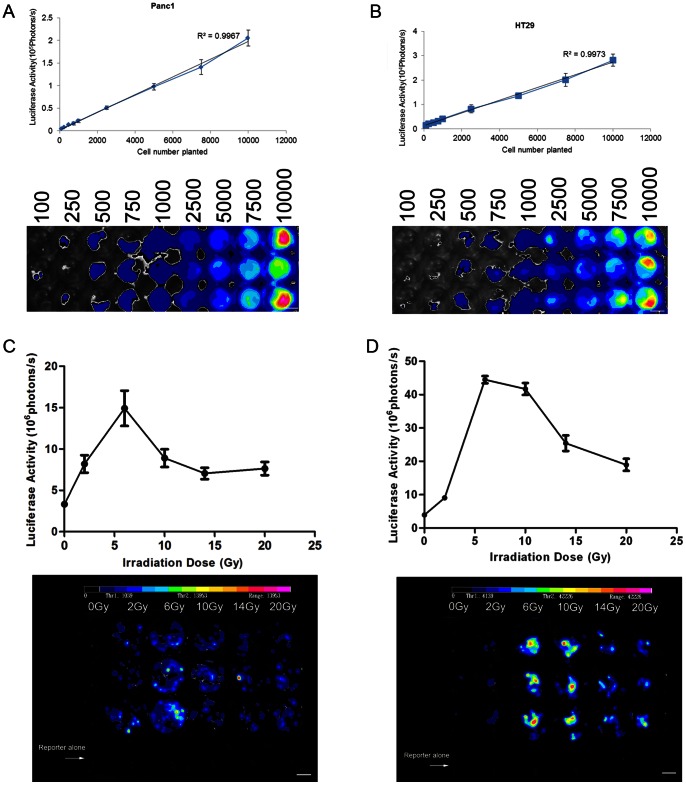
Growth-Stimulating properties of dying tumor cells irradiated at various doses.A. Correlation analysis of photons measured by bioluminescence imaging vs cell numbers plated. Fluc labeled Panc1 cells were plated in 96 well plates in 6 repeats at the number indicated the day before Imaging. The average photons/sec from 6 repeats at each cell numbers were analyzed by two-tailed ANOVA (R2 = 0.9967). The results indicated that intensity of image signal positively correlated with cell numbers plated. White scale bar represents 1 cm in length. B. Correlation analysis of photons measured by bioluminescence imaging vs cell numbers in HT29 cells. The procedure and result analysis were as same as Panc1 cells mentioned above (R2 = 0.9973). Scale bar represents 1 cm. C. Analysis of signal intensity of Panc1Fluc cells grown on irradiated Panc1 cells. 2.5×105 X-ray irradiated Panc1 cells were plated into 24 well plates as feeder. The doses were 0 Gy, 2 Gy, 6 Gy, 10 Gy, 14 Gy and 20 Gy respectively. 1000 Panc1Fluc cells were plated into each well with or without feeder cells as reporter. 14 days later plate was imaged for bioluminescence intensity. Top: Luciferase activity analysis; Bottom: representative bioluminescence image, scale bar represents 1 cm. D. Analysis of signal intensity of HT29Fluc cells grown on irradiated HT29 cells. The procedure and result analysis were as same as Panc1 cells mentioned above. Top: Luciferase activity; Bottom: representative bioluminescence image, scale bar represents 1 cm.